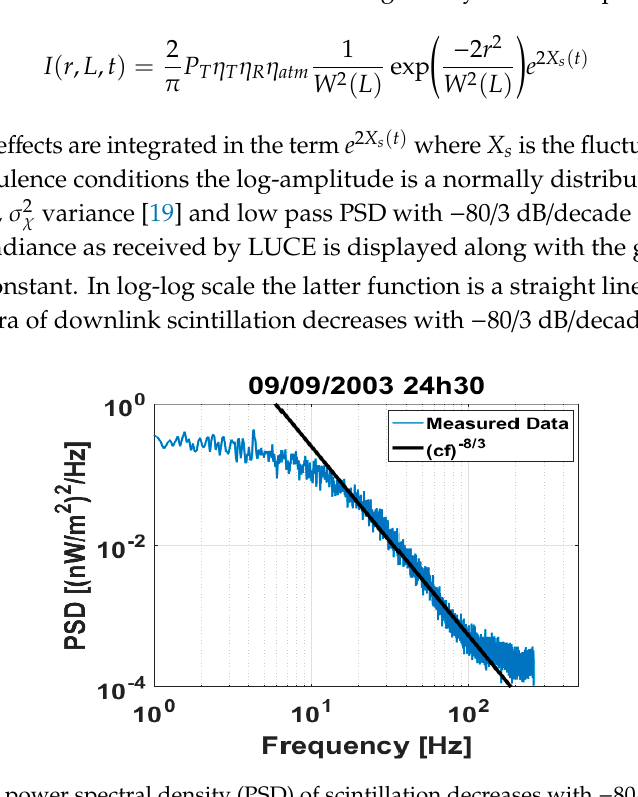
Figure 3. The power spectral density (PSD) of scintillation decreases with − 80/3 dB/decade.